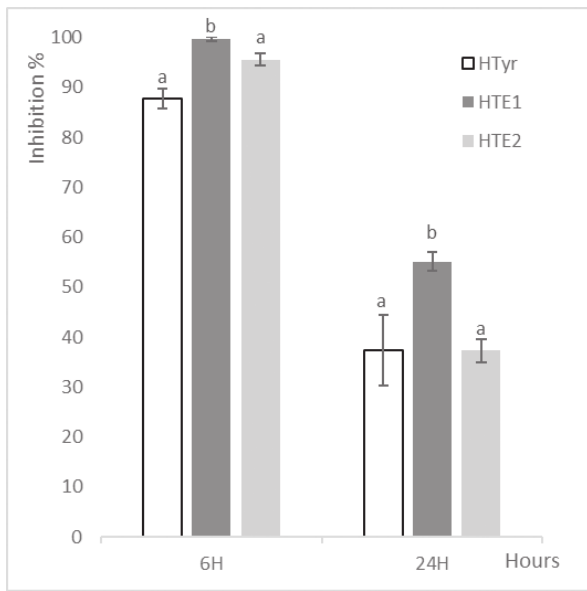
Figure 4. HTyr and HTE extracts mean inhibition (%) on Verticil- lium dahliae conidium germination. HTyr standard was tested at 1 mg mL -1 and HTE1 and HTE2 were tested at 1 mg mL -1 referred to the HTyr content in each extract. Germinated conidia were counted after 6 and 24 h incubation at 25°C in the dark, and means are for 100 conidia per replicate. Bars indicate standard errors, and differ- ent letters indicate significant differences ( P < 0.05), Tukey’s (HSD) multiple range